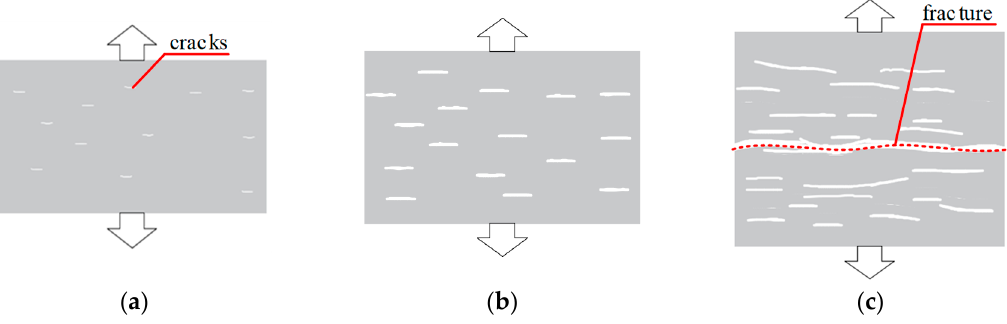
Figure 14. Failure process of plain TSL. ( a ) Tiny cracks occurred, ( b ) cracks propagated, ( c ) rupture occurred.